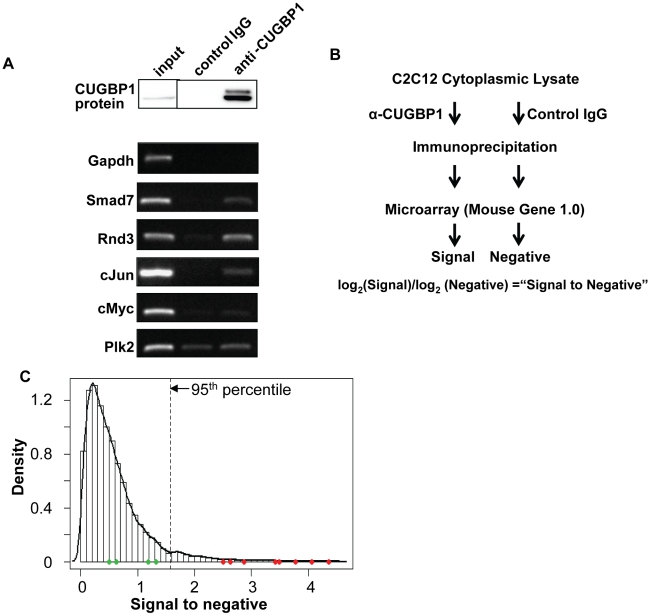
Identification of CUGBP1-associated mRNAs.(A) Western blot showing efficient immunoprecipitation of CUGBP1 from cytoplasmic extracts of C2C12 (LKO1) cells (upper panel). RT-PCR assays showing specific association of several transcripts with CUGBP1 immunoprecipitates. Gapdh, cMyc and Plk2 are negative controls. (B) Schematic of ribonucleoprotein immunoprecipitation microarray (RIP-Chip) experiment. The signal-to-negative ratio is the mean of probe set values of immunoprecipitated samples (α-CUGBP1) to that of negative control samples (control IgG). (C) Distribution of signal-to-negative ratios (see Dataset S2 for the complete list). The 95th-percentile value (indicated in the graph) was used as the cut-off for mRNAs showing a positive association with CUGBP1. The ratios for transcripts assayed by RT-PCR in (A) and Figure S3 are shown as dots with red and green colors representing positive and negative immunoprecipitation, respectively.